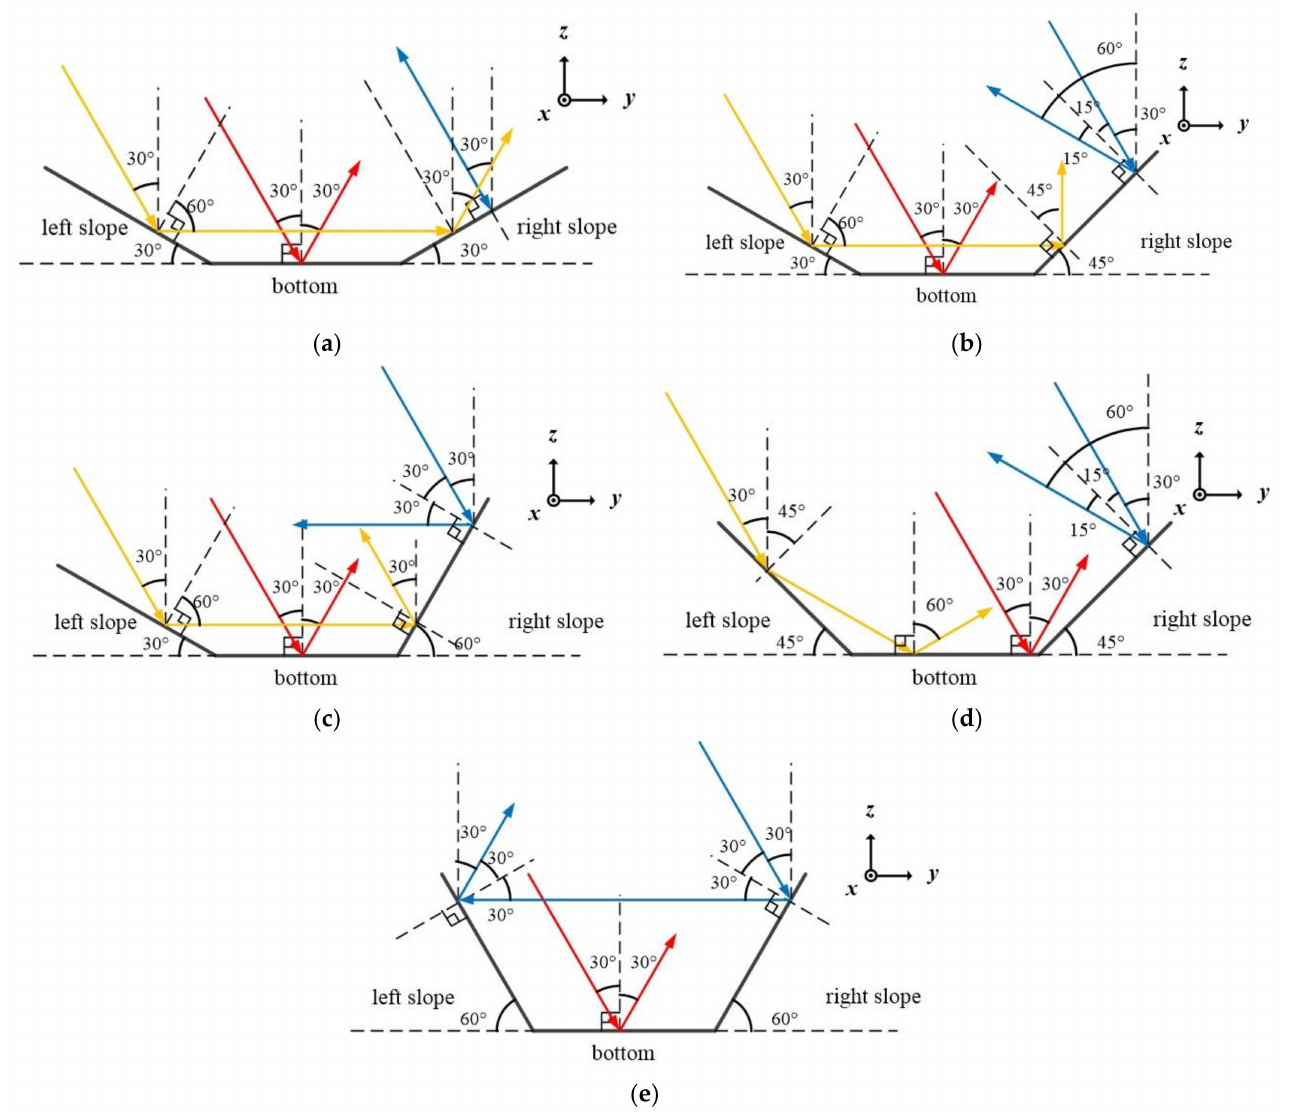
Figure 14. Illustration of EM wave propagation paths in canyon/valley: ( a ) α 1 = 30 ◦ , α 3 = 30 ◦ ; ( b ) α 1 = 30 ◦ , α 3 = 45 ◦ ; ( c ) α 1 = 30 ◦ , α 3 = 60 ◦ ; ( d ) α 1 = 45 ◦ , α 3 = 45 ◦ ; ( e ) α 1 = 60 ◦ , α 3 = 60 ◦